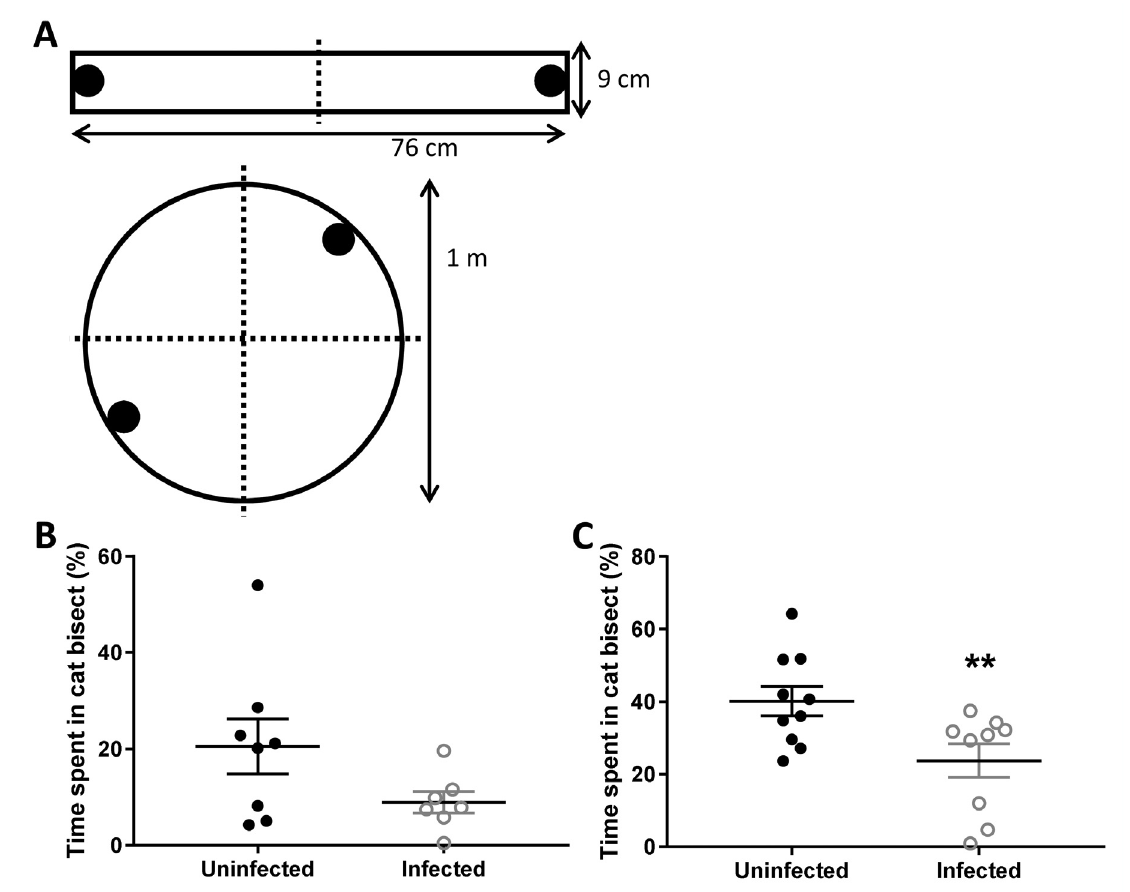
Figure 1. Toxoplasma gondii -infected female rats showed increased aversion to bobcat odor in two sequential experiments. Panel A depicts schematics of test arenas used in the experiments later depicted in panels B and C . Ordinate for panel B and panel C depicts time spent by female rats chronically infected with Toxoplasma gondii near bobcat odor. Line graphs depict mean and standard error of the mean for control (black) and infected (gray) female rats. *, p < 0.05; unpaired two-tailed Student’s t-test (n = 8 uninfected and 7 infected animals for panel A ; and 10 uninfected and 9 infected animals for panel B